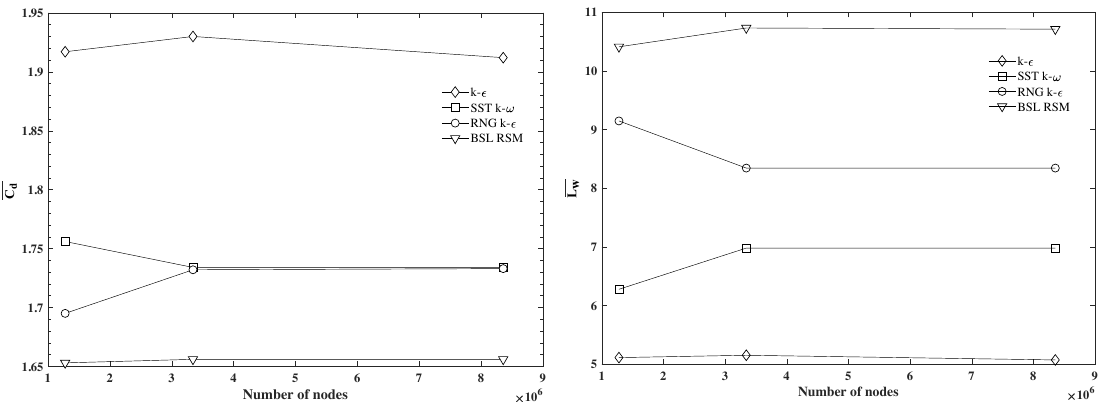
Figure 2. Grid independence study for C d and L w